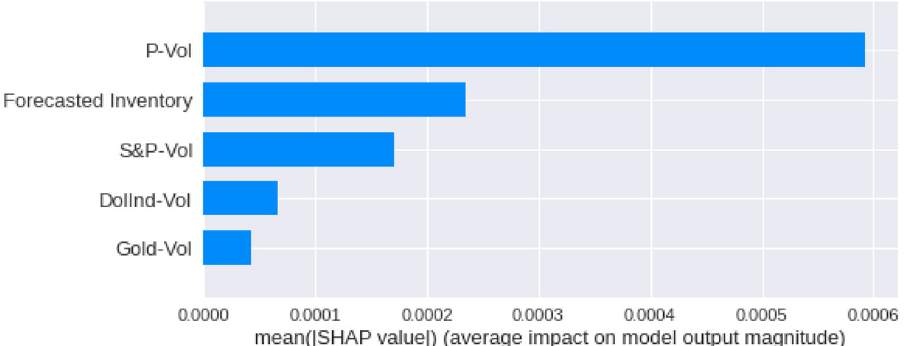
Fig 21. Mean Shapley values for the third previous day using Nadam